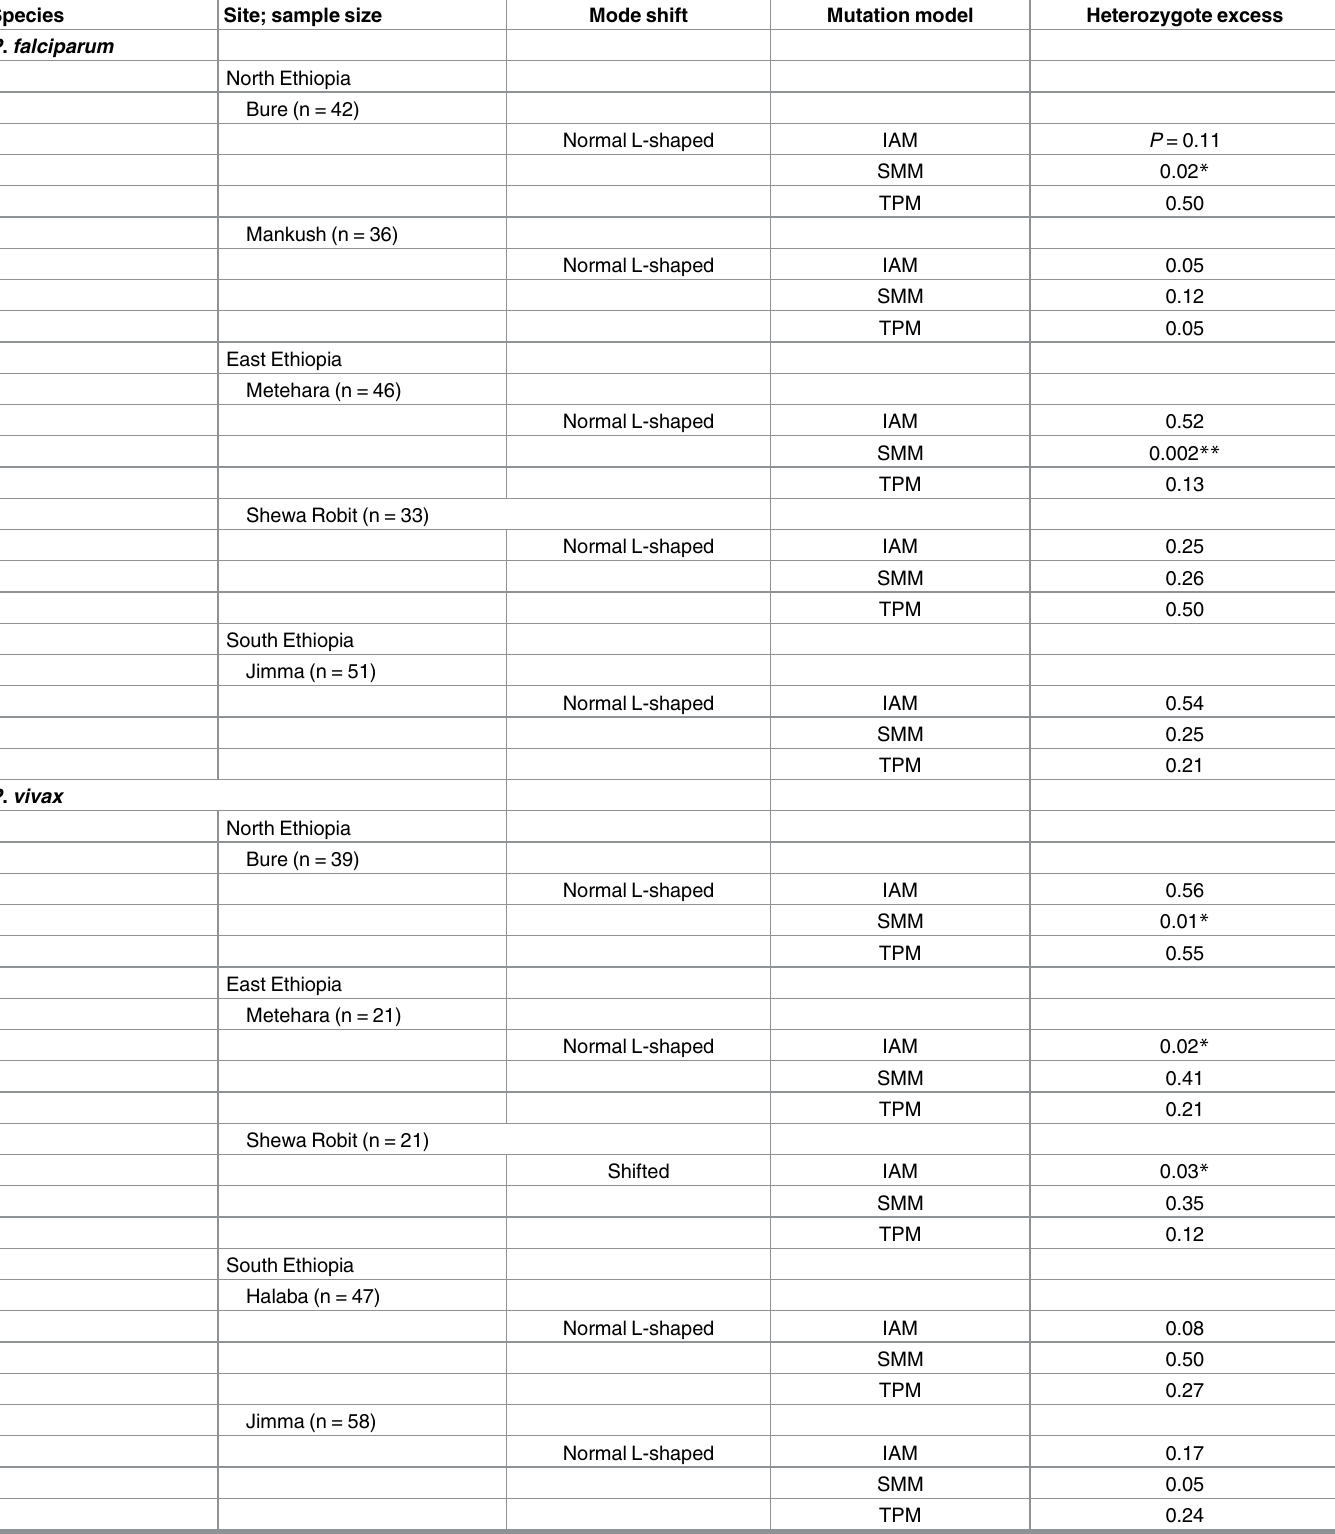
Table 4. Summaryof the parameters and results based on BOTTLENECK